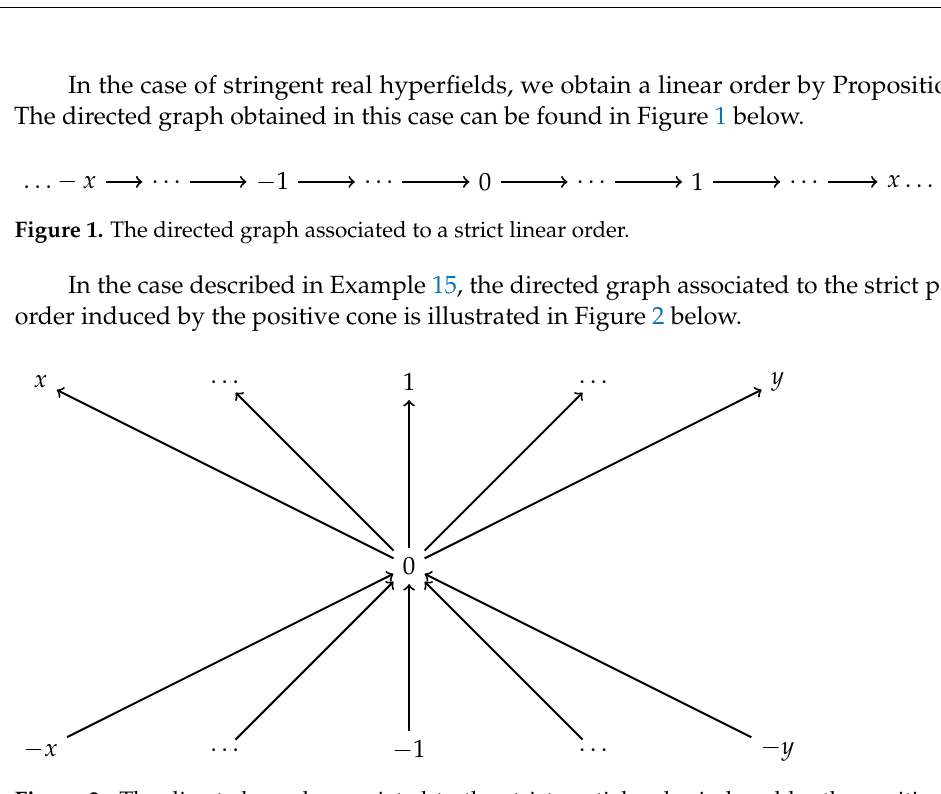
Figure 2. The directed graph associated to the strict partial order induced by the positive cone described in Example